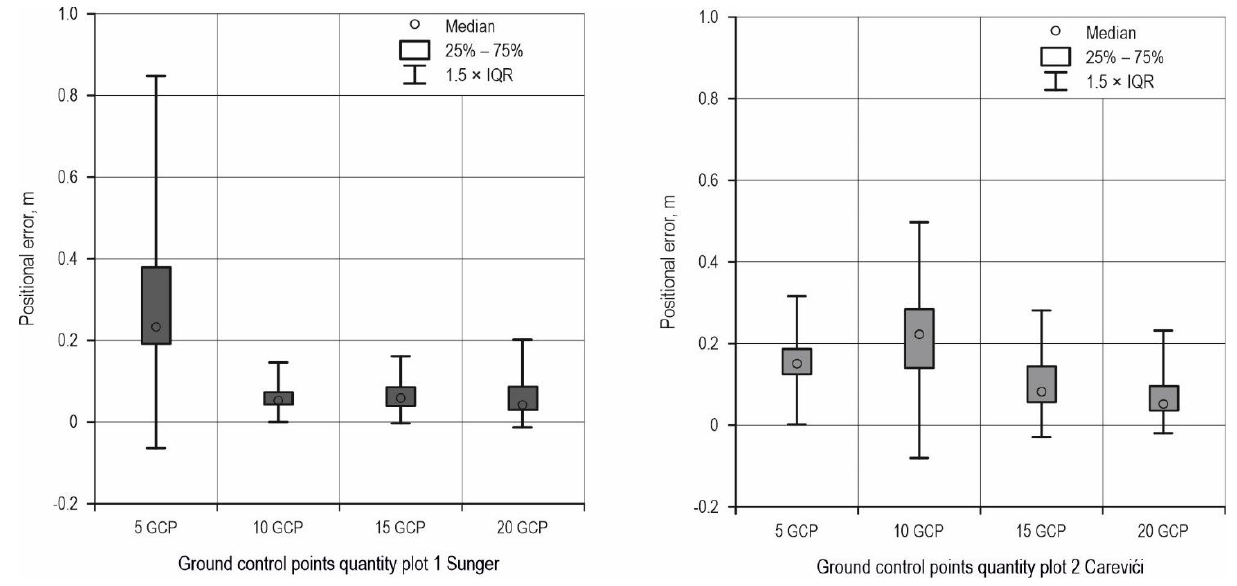
Figure 6. Positional error in Plots 1 and 2.